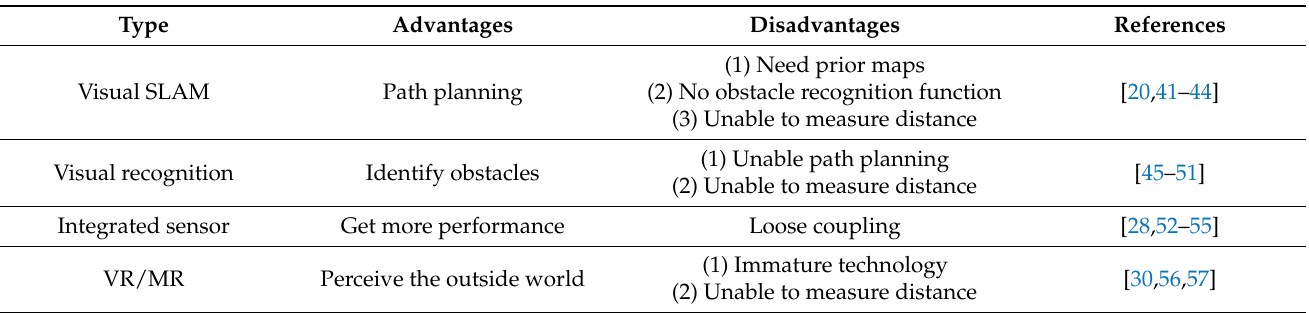
Table 2. Summary of various Visual sensing smart